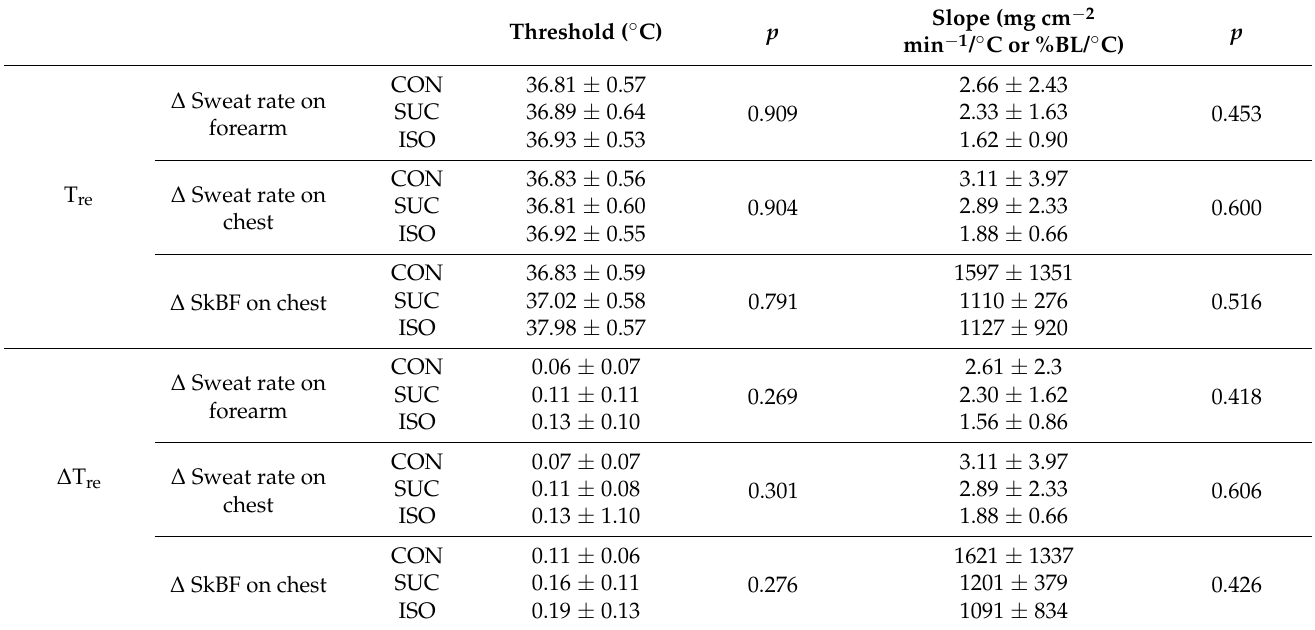
Figure 5. Changes in sweat rate on the forearm and chest, and skin blood flow (SkBF) on the chest, as a function of change in rectal temperature ( ∆ T re ) during exercise. CON, control (water); SUC, sucrose; ISO, isomaltulose; BL, baseline. Values are shown as means ± SD. n = 9 for all variables. Table 3. Rectal temperature thresholds and slopes for sweating and cutaneous vasodilation in each trial.